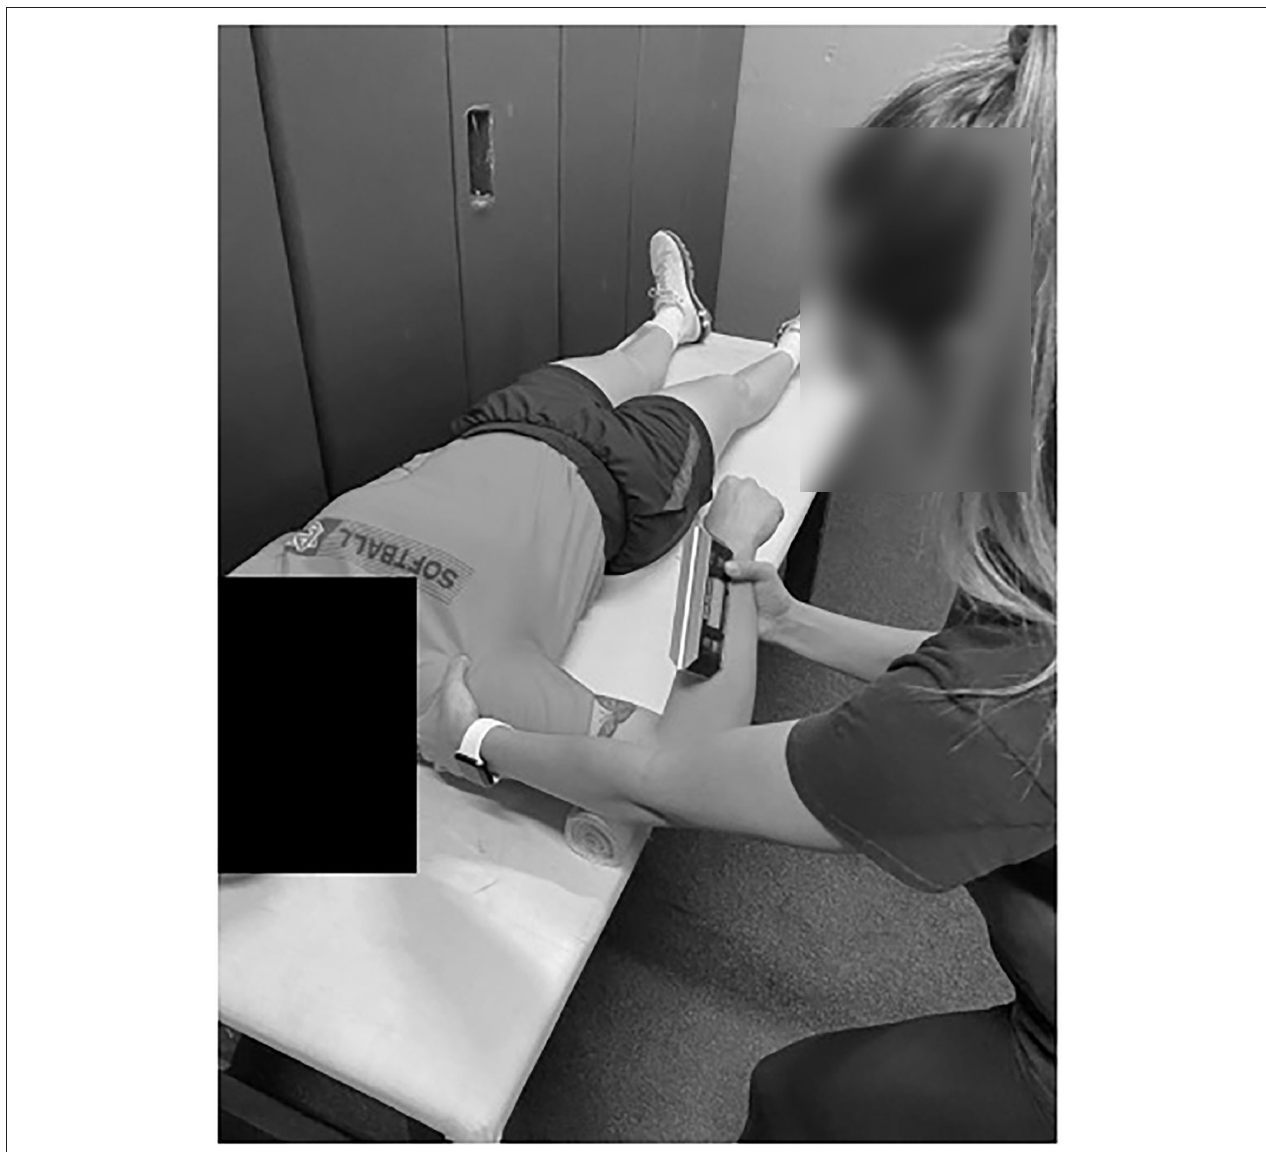
FIGURE 4 | Shoulder IR ROM